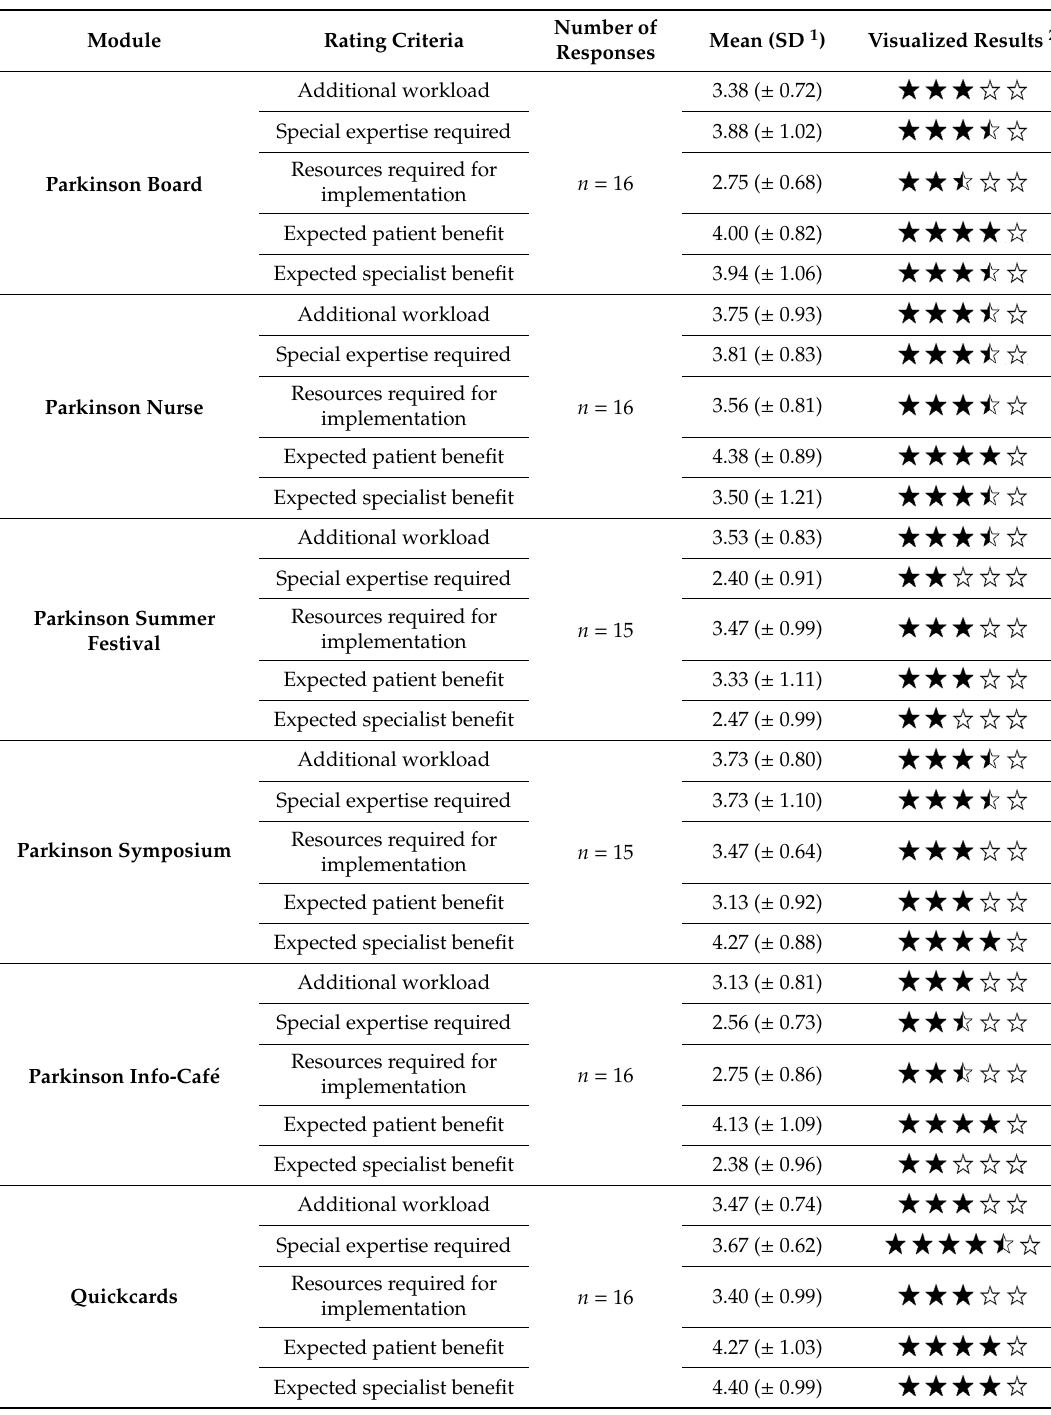
Figure 3. Box Plots for the Rating Categories and Rating Values (Modules: n = 25, Raters: n = 17) .